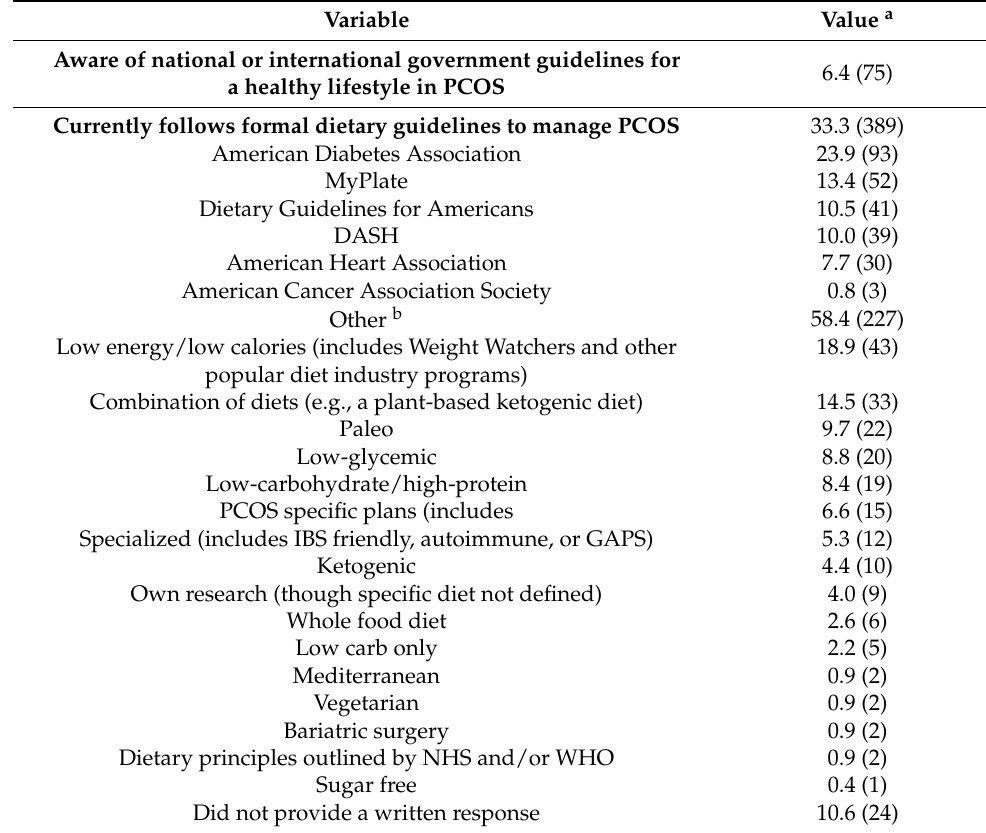
Table 3. Knowledge of formal dietary and physical activity guidelines and special diets and physical activity plans followed by women with polycystic ovary